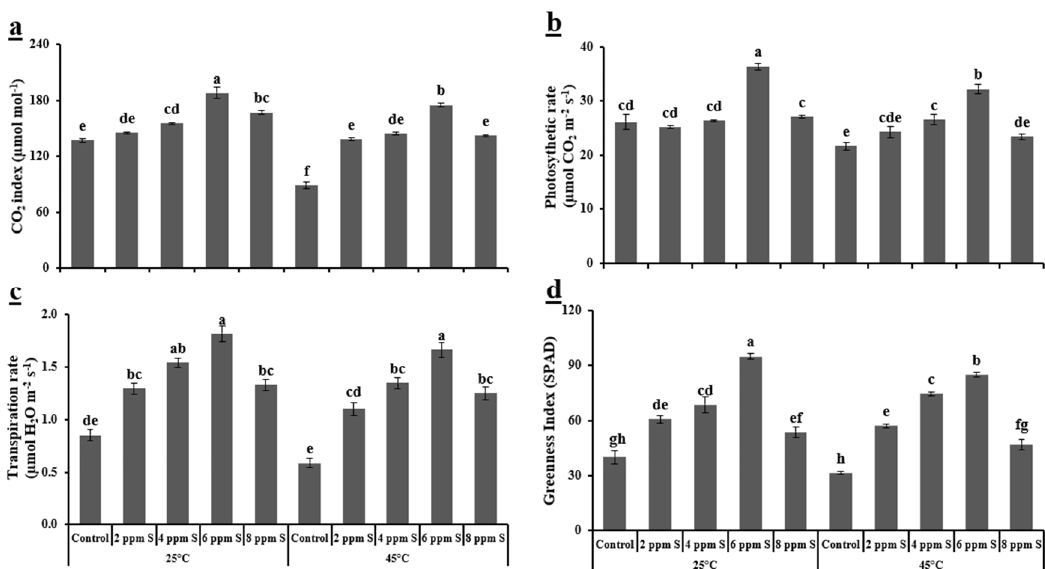
Figure 2. Physiological variables [i.e., CO 2 index ( a ), photosynthetic rate ( b ), transpiration rate ( c ), greenness index ( d )] of tomato plants (cv. Roma) as affected by temperature and exogenous application of S. Same letters indicate non-significant differences among treatments according to Tukey’s honestly significant difference test ( p ≤ 0.05). Vertical bars indicate averages ± standard errors ( n = 4, 5 plants per replicate).